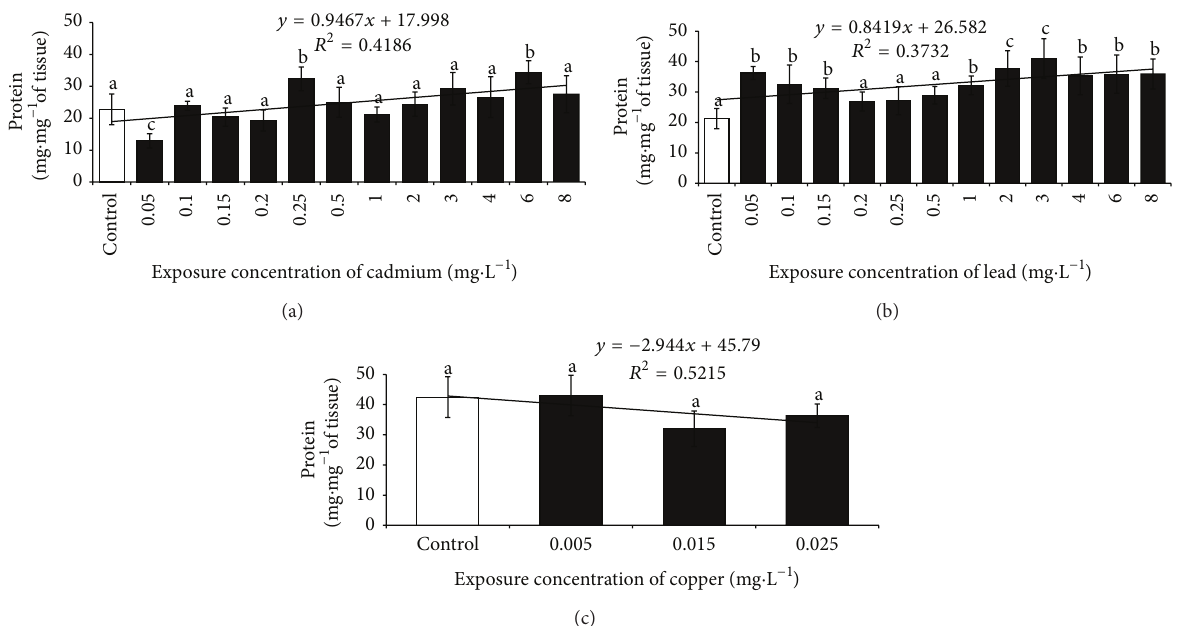
Figure 1: Mean ( ± SD) variation of total protein in Perna perna of control and Cd-exposed (a), Pb-exposed (b), and Cu-exposed mussels (c) after 72 h exposure. Values followed by the same letter are not statistically different ( 𝑃 > 0.05 ) but values followed by the different letter are statistically significant ( 𝑃 < 0.05